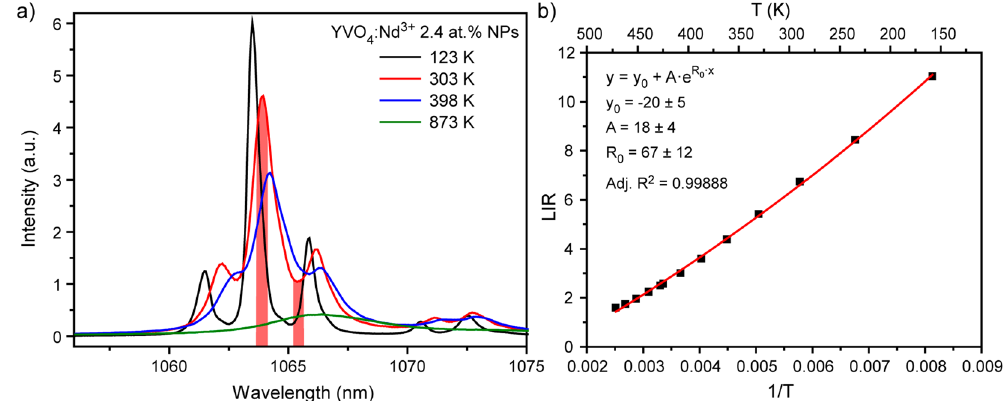
Figure 1. ( a ) Emission spectra of YVO 4 :Nd 3 + 2.4 at.% NPs obtained at different temperatures; ( b ) evolution of luminescence intensity ratio between peak 1063.9 nm and valley 1065.3 nm (T = 123–398